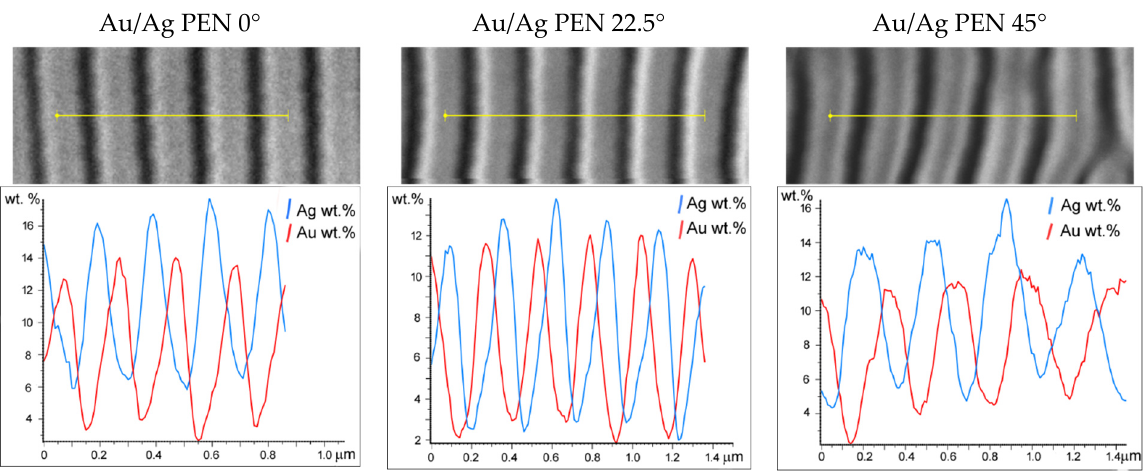
Figure 4. The concentrations of Au, Ag, C and O on Au/Ag PEN 0/22.5/45° samples determined by AR-XPS.